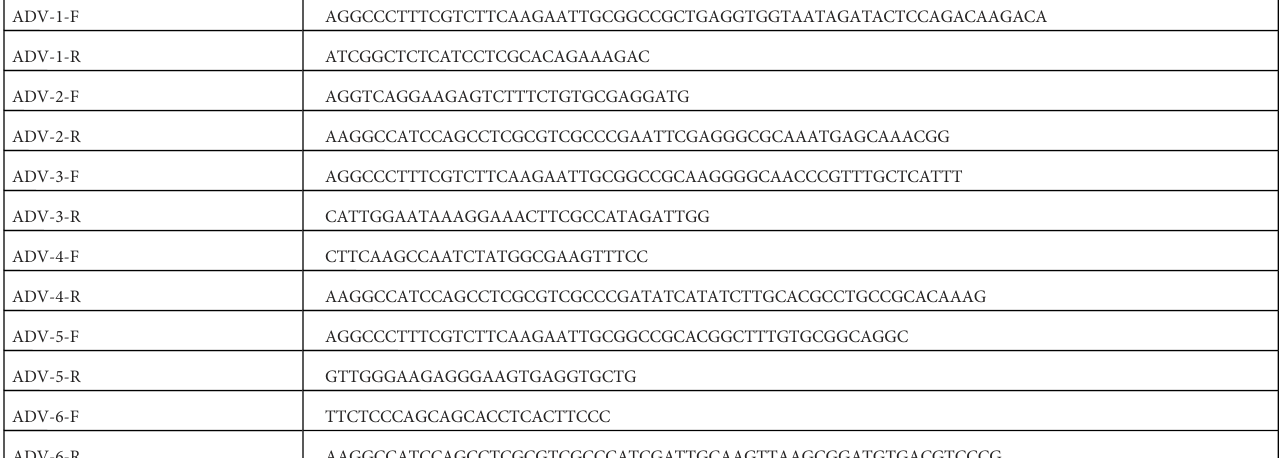
TABLE 1 Speci fi c primers for the ampli fi cation of the six adenovirus fragments.